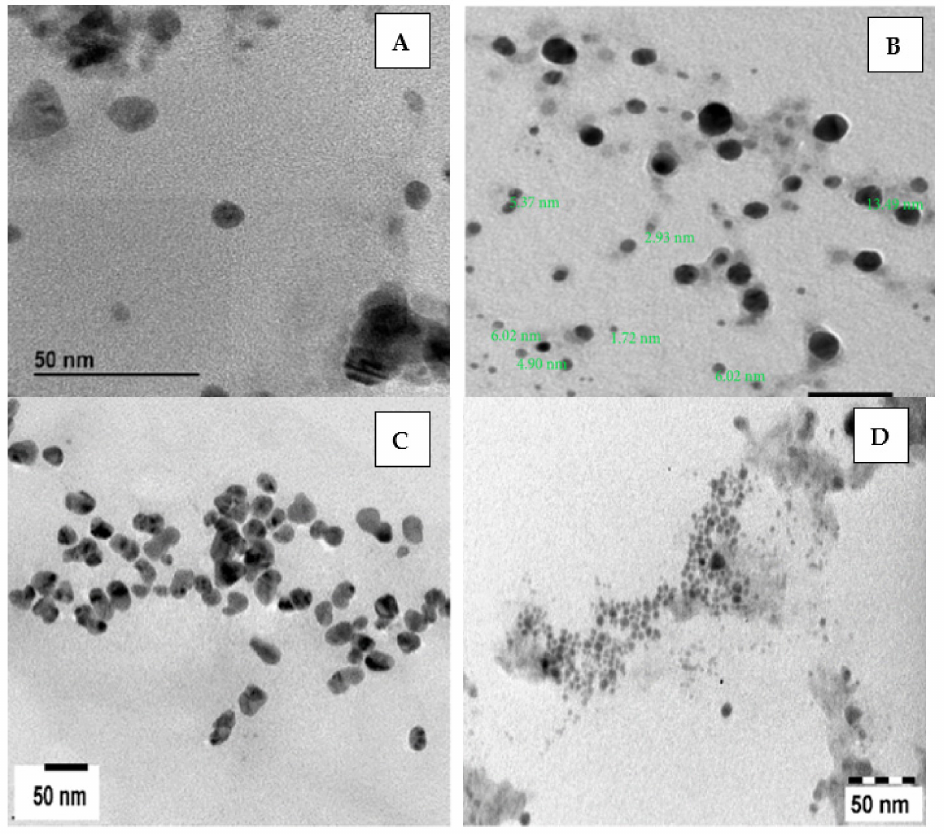
Figure 4. TEM images of different bacterial synthesized nanoparticles. ( A ) Silver nanoparticles (from Pseudoduganella eburnea ); ( B ) copper oxide nanoparticles (from Streptomyces ); ( C ) silver nanoparticles (from Sargassum incisifolium ), and ( D ) gold nanoparticles (from Sargassum incisifolium )